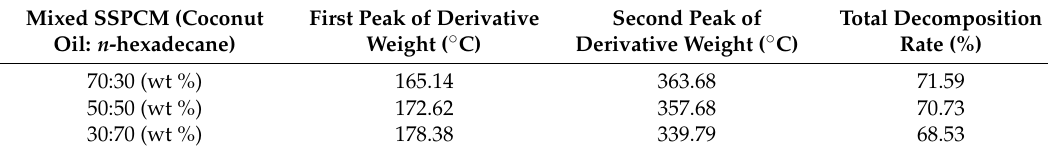
Figure 5. Thermogravimetric analysis (TGA) graphs of Mixed SSPCMs. Table 6. TGA analysis of Mixed SSPCMs.